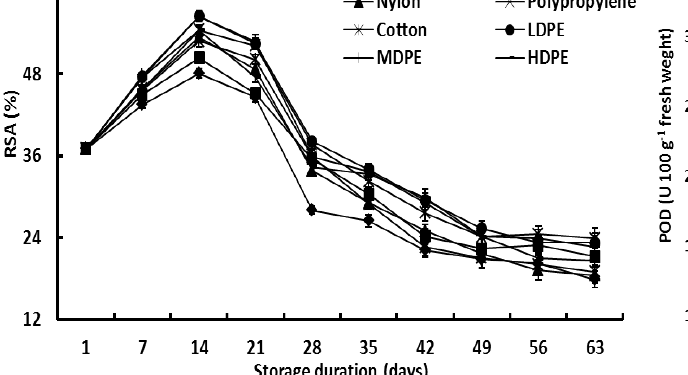
Fig. 8: Peroxidase (POD) in potato tubers stored in different packaging ma- terials was lowest by the end of the storage period when stored in polypropylene and LDPE. Vertical bars show ±SE of means (n-3). Interaction between storage intervals and packaging materials was significantly different at p ≤